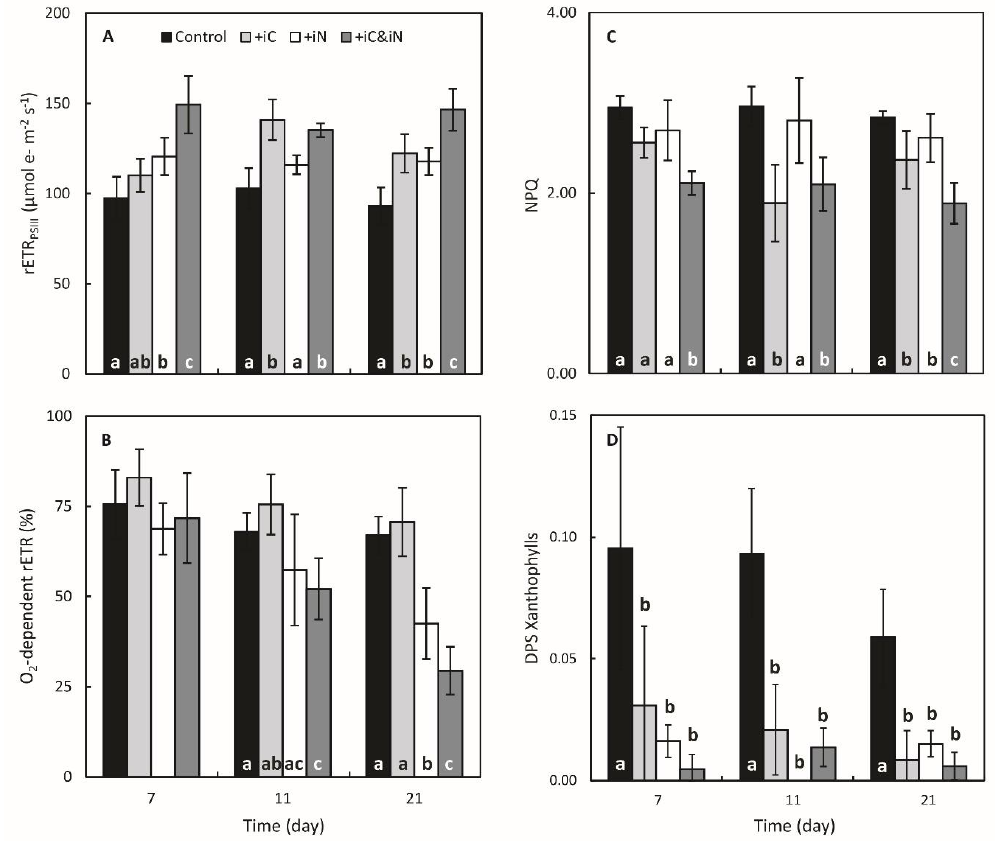
Figure 3. Evolution of the photosynthetic parameters of the endosymbionts of S. pistillata exposed for 3 weeks to natural seawater (control) and to seawater enriched with 6 mM HCO 3− (+iC) or 4 µM NH 4+ (+iN) or both (+iC & iN). ( A ) the relative electron transport rate through PSII (rETR PSII ; µmol e − m −2 s −1 ) at 600 µmol photons m −2 s −1 , ( B ) the O 2 -dependent rETR at the induction of photosynthesis (%), ( C ) the non-photochemical quenching (NPQ) at 600 µmol photons m −2 s −1 and, ( D ) the de-epoxidation state of the xanthophylls cycle (DPS; was measured after 15 min of illumination with 400 µmol photons m −2 s −1 as the ratio of Diatoxanthin (Dtx) to Diadinoxanthin (Ddx) + Dtx. Data are presented as mean ± SD ( n = 6). Different letters indicate statistically significant differences between each treatment for one time point ( P < 0.05).